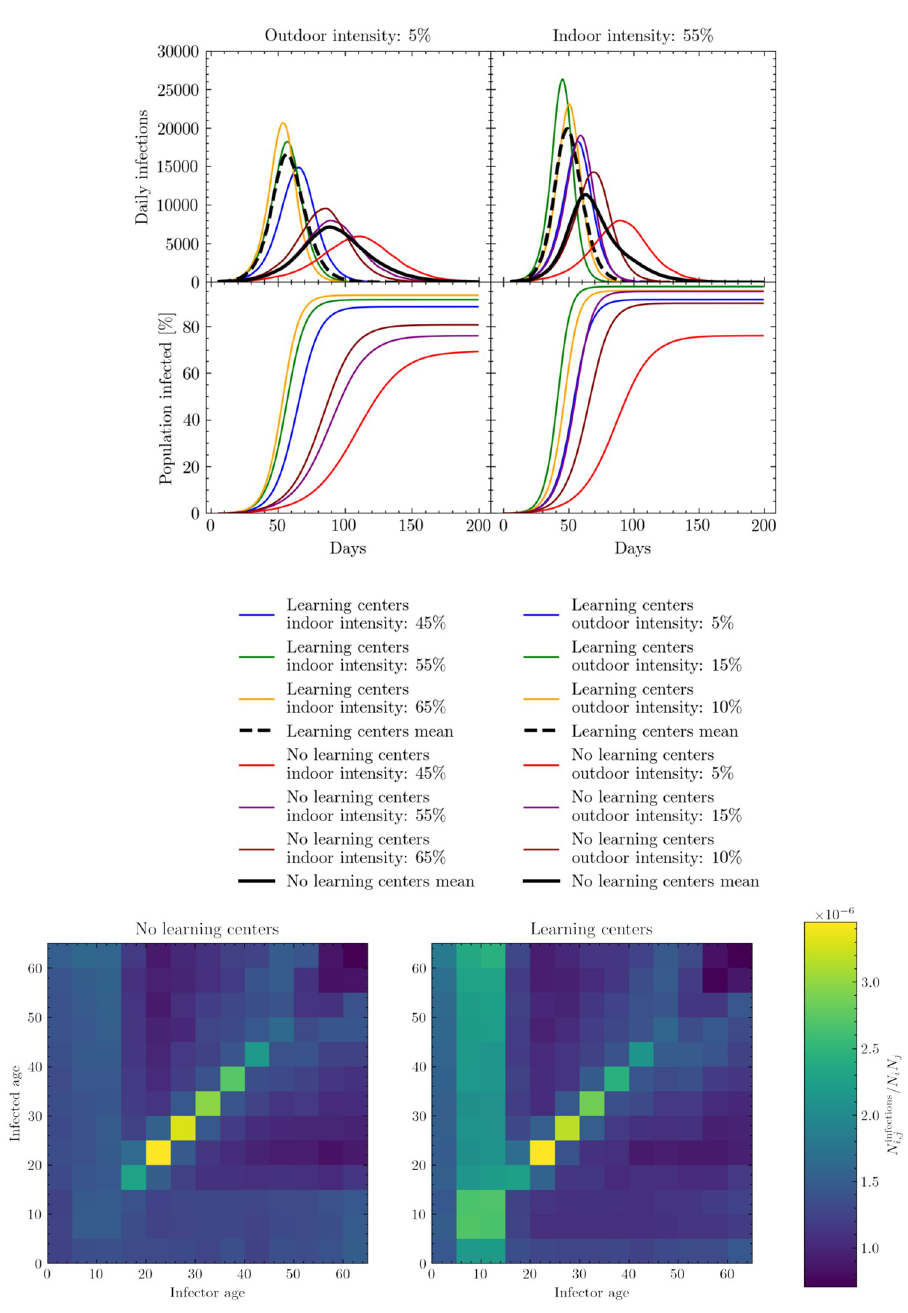
Fig 8. Learning center opening simulation results. Upper: Simulated daily (7-day rolling average) and cumulative infections measured in days since the beginning of the simulation. Results show the effects of varying indoor (left) and outdoor (right) interaction intensity parameters relative to the interaction intensity parameter set for the shelter. These intensity parameters are varied in both the baseline models and those with learning centers open. See S1 Table for a presentation of the cumulative number of infections, peak intensity and peak timings for these scenarios. Lower: Simulated number of cumulative infections in one age group produced by another age group normalised by group sizes. We assume the baseline interaction intensities